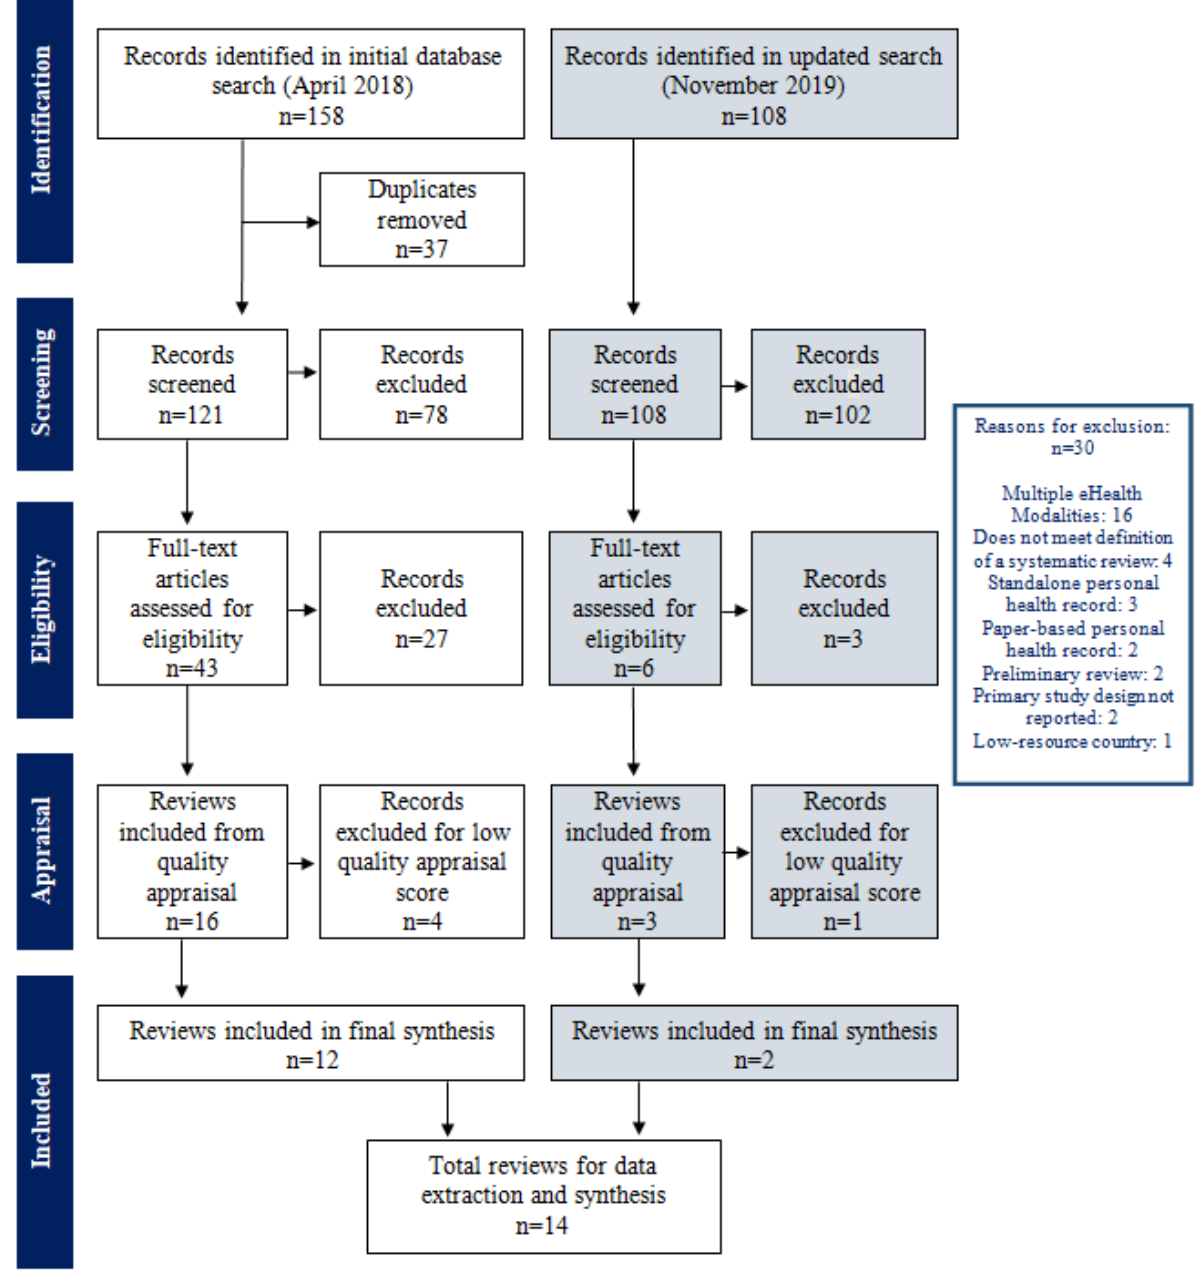
Figure 1. The PRISMA (Preferred Reporting Items for Systematic Reviews and Meta-Analyses) flow